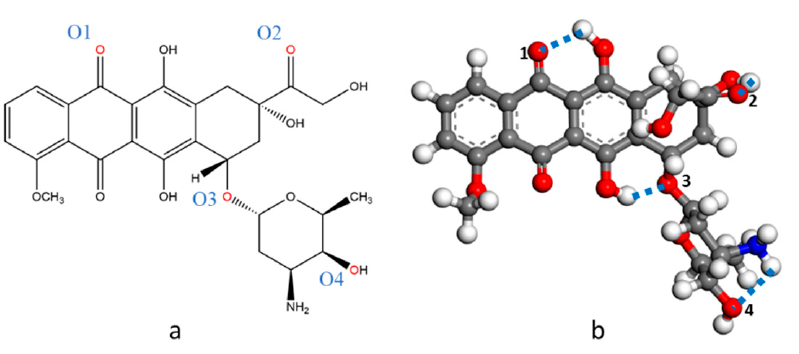
Figure 1. Representation of doxorubicin (DOX) structure. ( a ) 2D; ( b ) 3D. Color code: C, gray; O, red; N, blue; H, white.